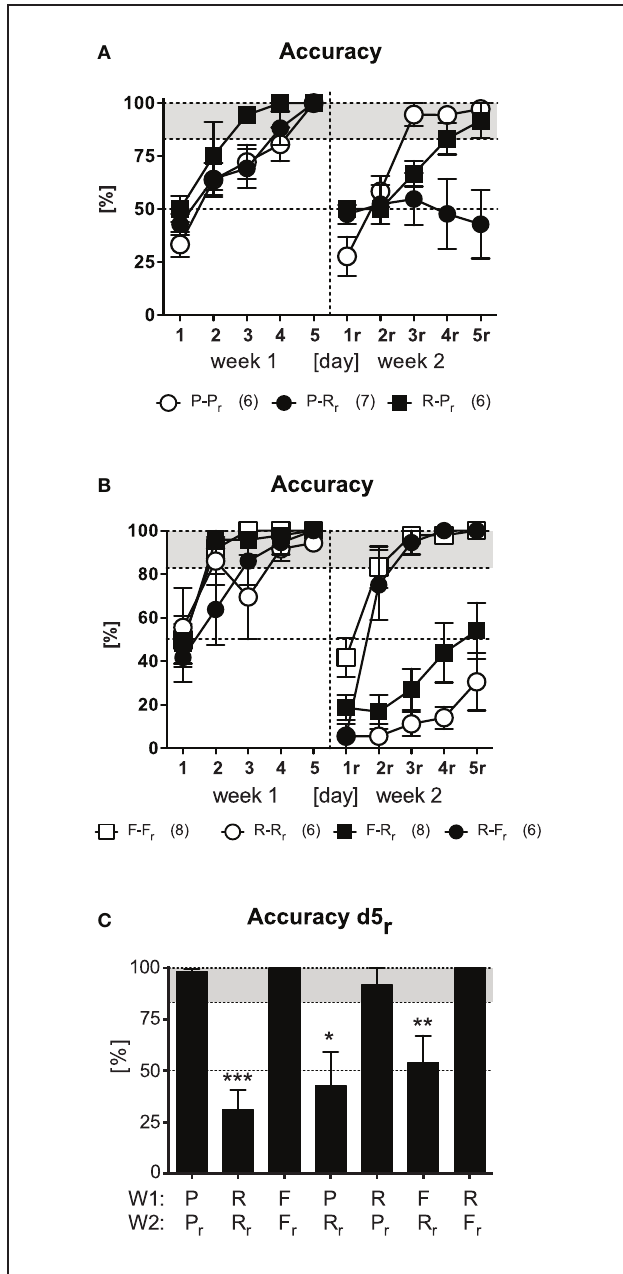
FIGURE 3 | Strategy switching. Four strategy switching protocols (P-R r , R-P r , F-R r , R-F r ) were used (cf. Figure 1B ). Reversal protocols (F-F r , R-R r ) were carried as control and replication. (A) After accurate learning in